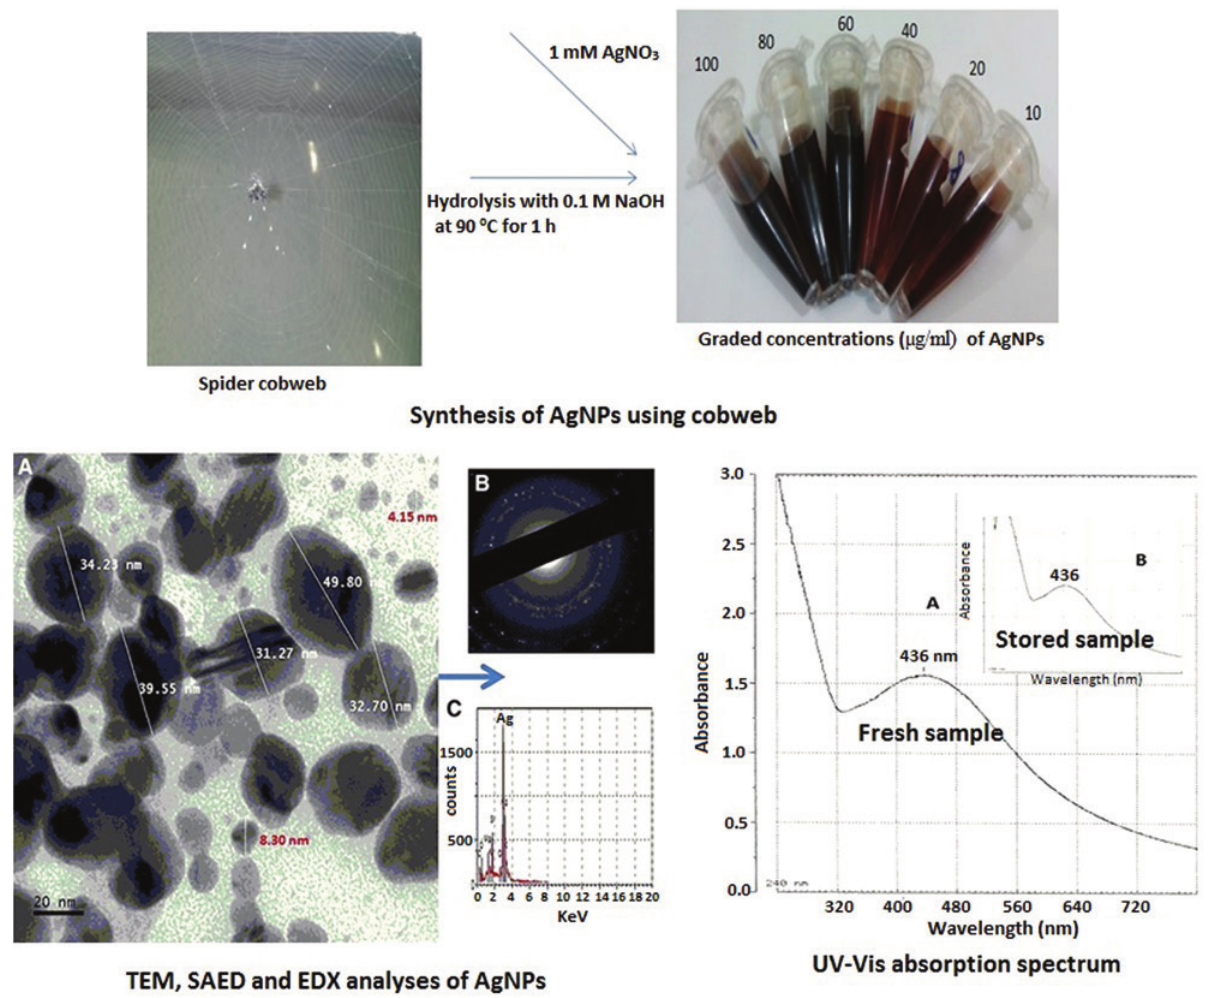
Figure 1: Green synthesis of AgNPs using cobweb extract and the characteristics of biosynthesized AgNPs.